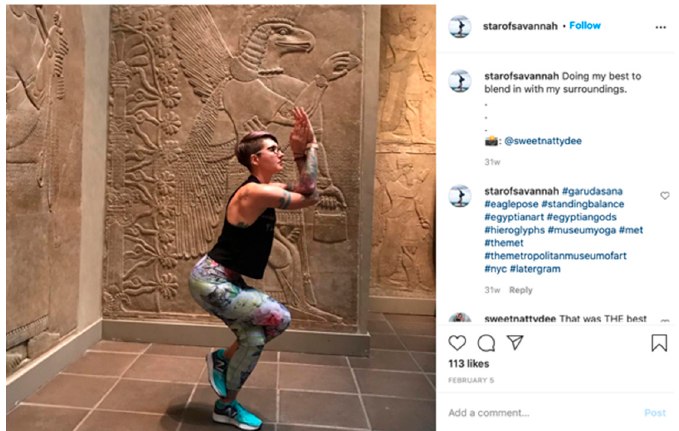
Figure 8. #museumyoga, on left, a white woman performs “eagle pose” with an eagle carving in the background. Photo Source: Instagram.